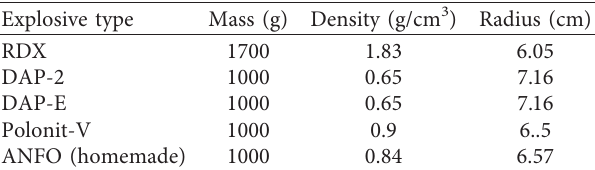
Table 1: Explosive type and